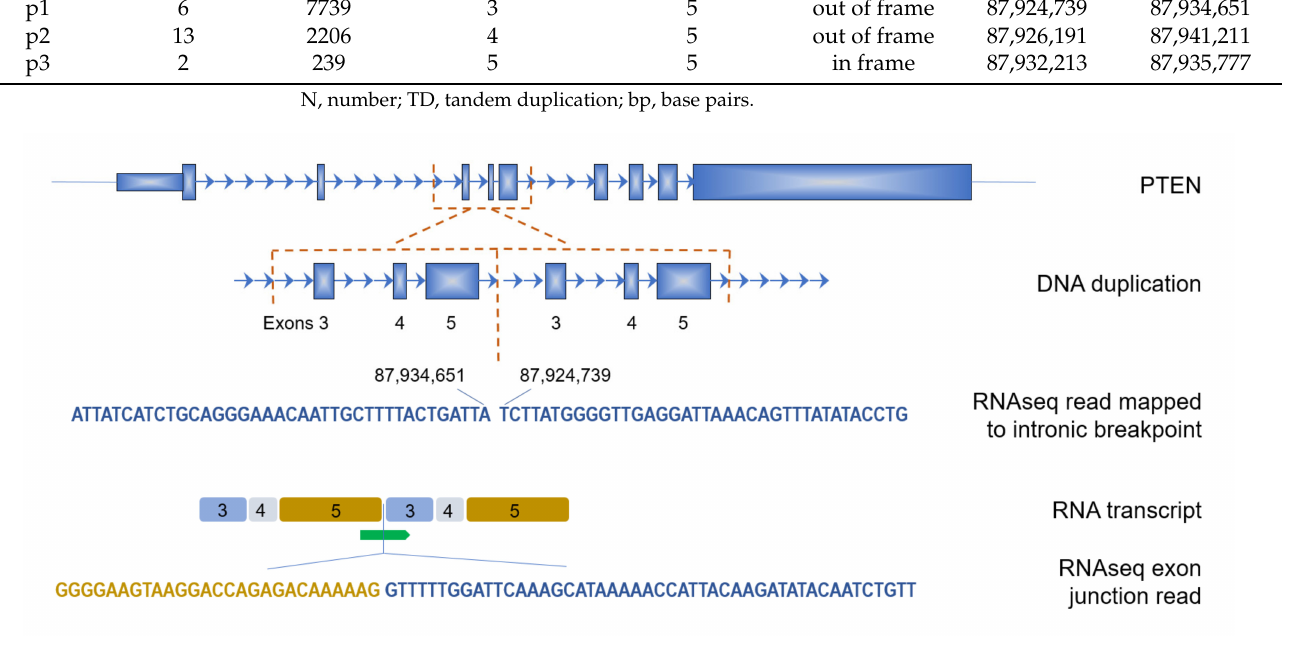
Figure 4. Example of a TD in PTEN . DNA breakpoints were identified before exon 3 and after exon 5, leading to a TD of these 3 exons. In the RNAseq data, sequence reads were identified spanning both the intron breakpoints as well as the resulting transcriptome junction of exon 5 to exon 3. Introns are indicated by the arrowed lines and are not to scale. Coordinates are from the GRCh38 reference